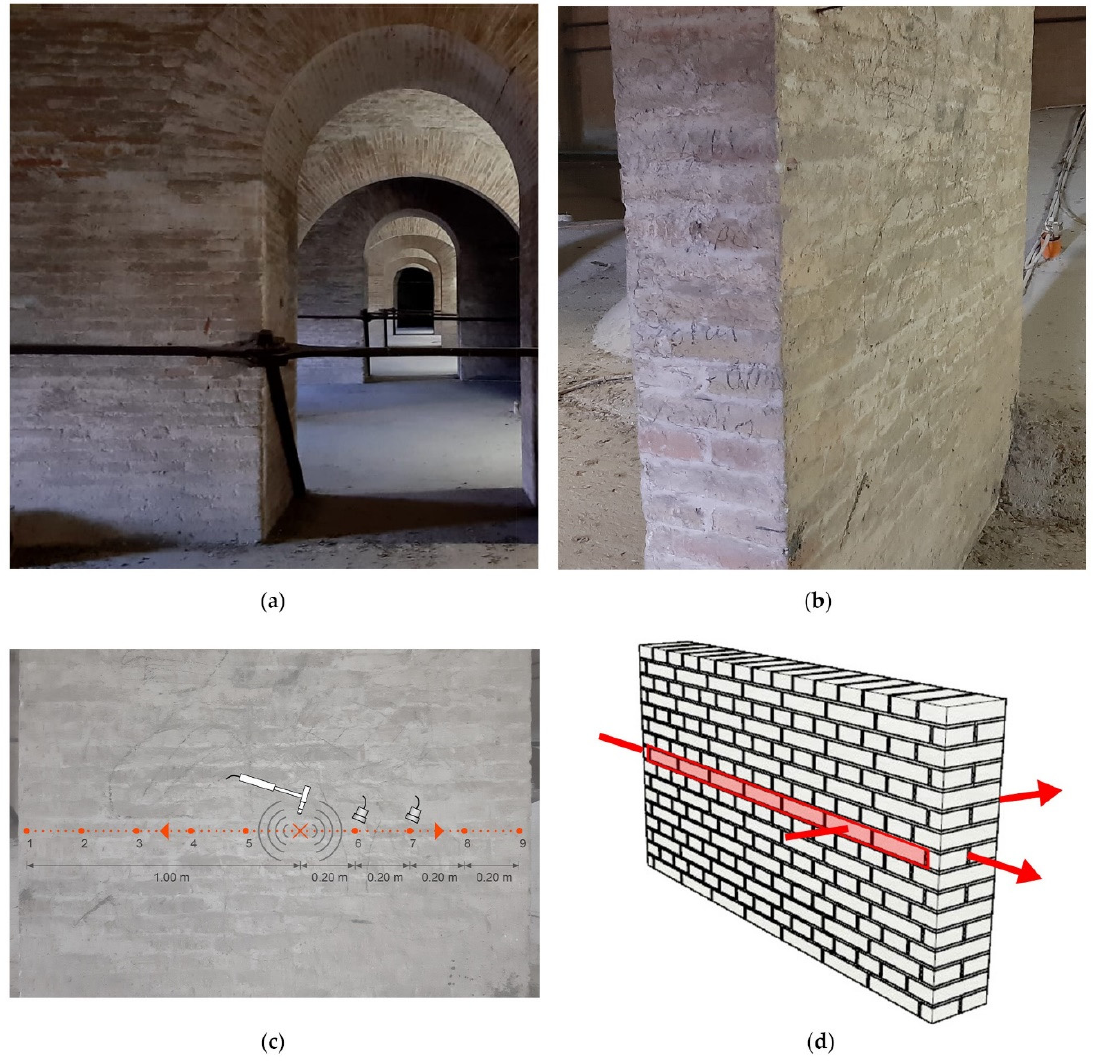
Figure 9. ( a ) Tested masonry wall: buttresses of the central nave located above the aisle reinforced with steel tie rods added in the latest restoration; ( b ) Schematic representation of the positioning of the accelerometers on the wall and point of impact of the instrumented hammer; ( c ) Schematic representation of indirect test configuration denoting the position of the accelerometers and the impact point of the instrumented hammer; ( d ) Schematic representation of direct test configuration denoting the directions of volume waves propagation.